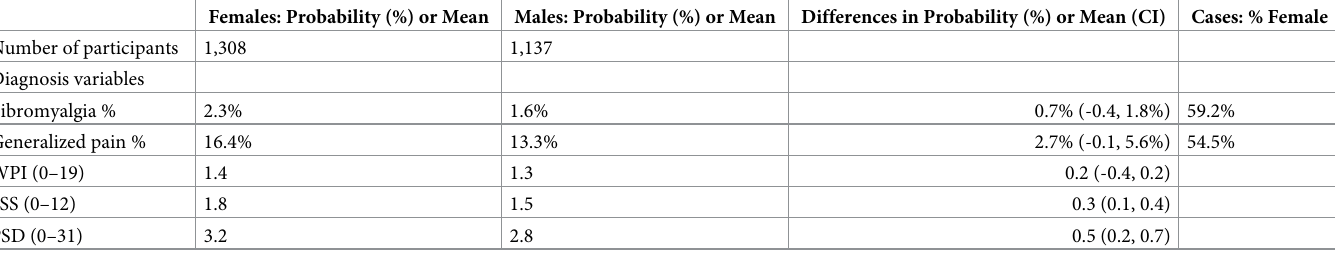
Table 2. Probabilities and symptom score related to fibromyalgia according to gender among persons in the German general population (S3 File). Females: Probability (%) or Mean Males: Probability (%) or Mean